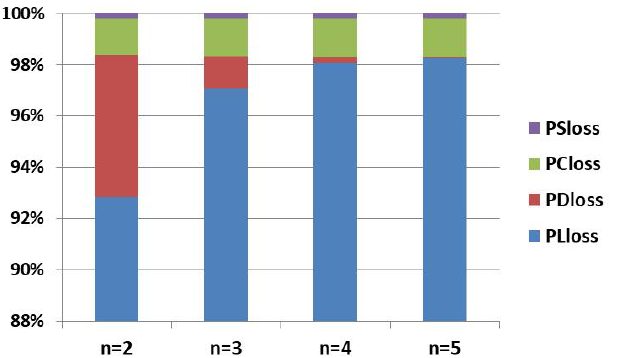
Figure 8. The proportion of each part loss to total loss in different n .